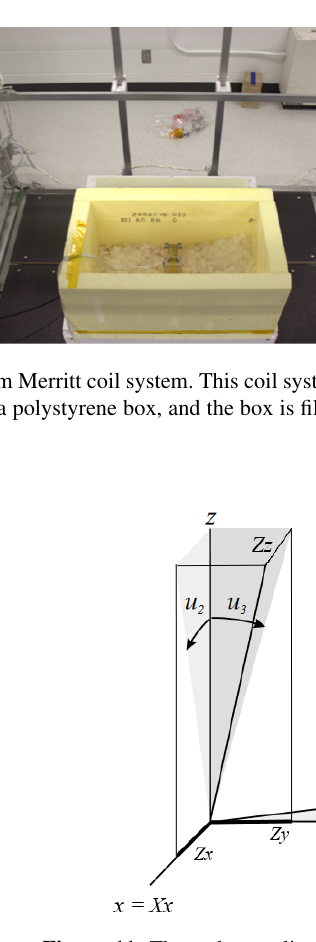
Figure 11. The orthogonality angles are defined according to the convention from Olsen et al. (2003). Equations (2), (3), and (4) are different for u 1 because the Olsen et al. (2003) convention defines the x axis as projection-invariant, the y axis has a single degree of freedom on the x − y plane, and the z axis has 2 degrees of